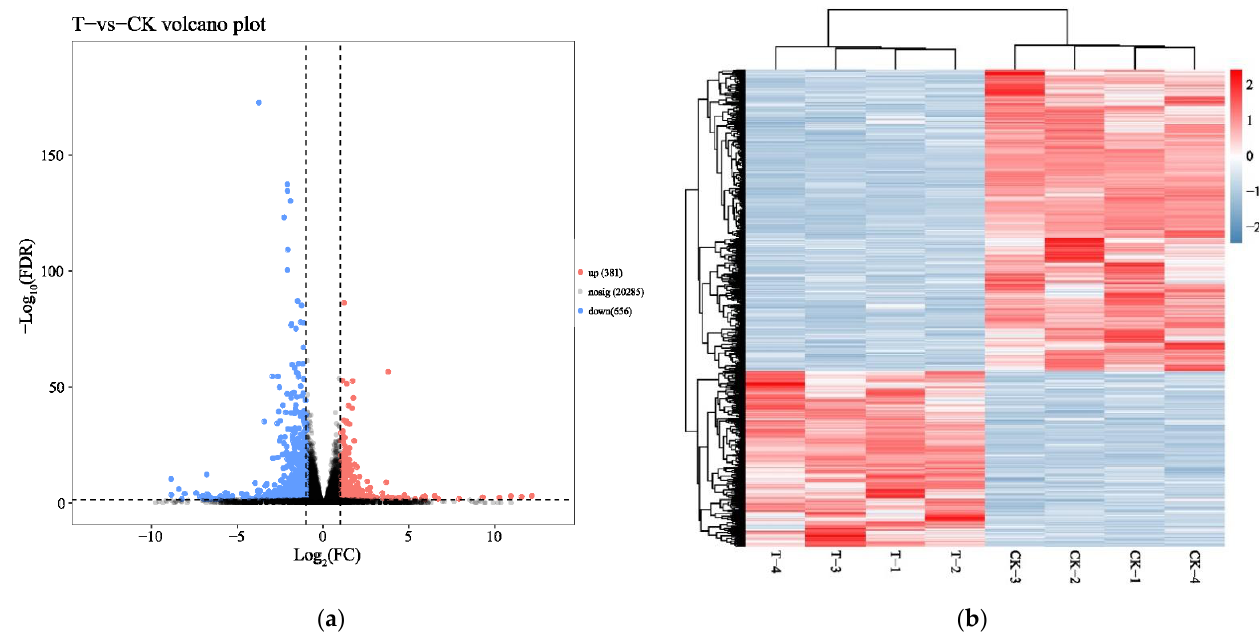
Figure 1. Identification of differentially expressed messenger RNAs (mRNAs) in response to naringenin. ( a ) Volcano plot showed that all non-redundant unigenes were identified in the control group and the naringenin group. The 20,285 gray dots represent non-significantly differentially expressed mRNAs, the 381 red dots represent significantly differentially up-regulated mRNAs, and the 656 blue dots represent significantly differentially down-regulated mRNAs; FC (fold change) = the naringenin group/the control group; FDR (false discovery rate), the expected percent of false predictions in the set of predictions; ( b ) heat map showing 1037 differentially expressed genes (DEGs), comparing the control group with the naringenin group. Each row represents one mRNA, and each column represents a sample. Red, upregulation; blue, downregulation; CK-1, CK-2, CK-3, and CK-4, the control group; T-1, T-2, T-3, and T-4, the naringenin group.